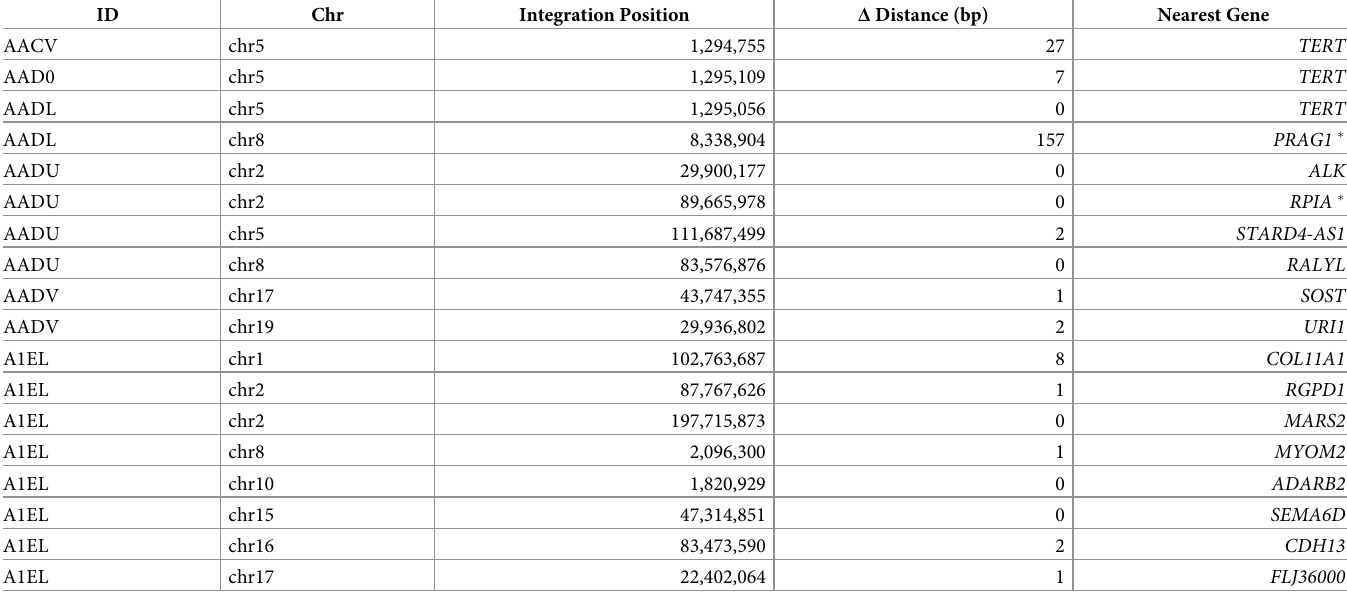
Table 2. HBV integration sites in 6 WES samples.